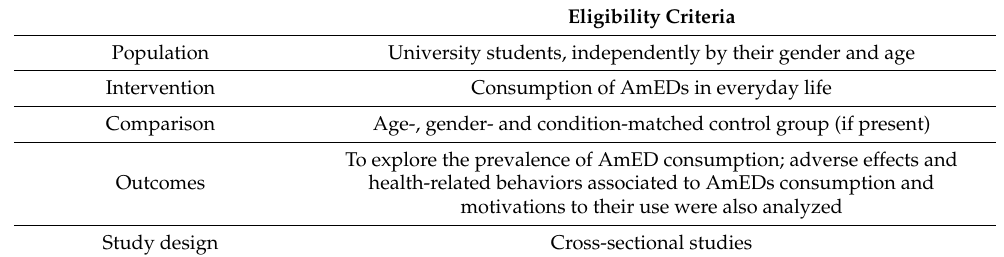
Table 1. Eligibility criteria used in the article selection process based on the PICOS